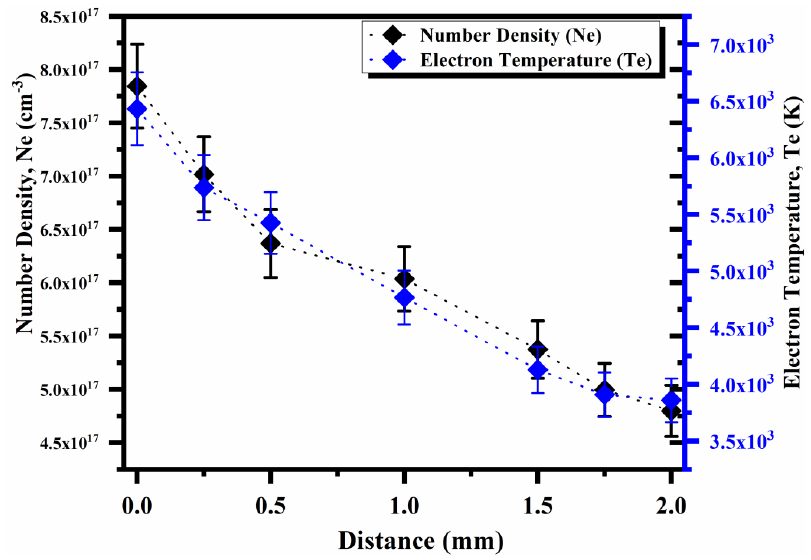
Figure 6. Variation in the electron temperature and the electron number density for Ga as a function of distance.